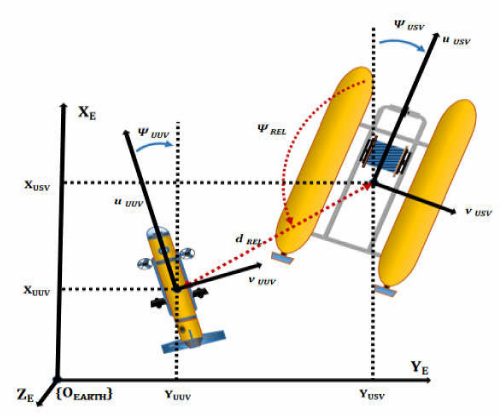
Figure 19. Graphical description of d REL and ψ REL